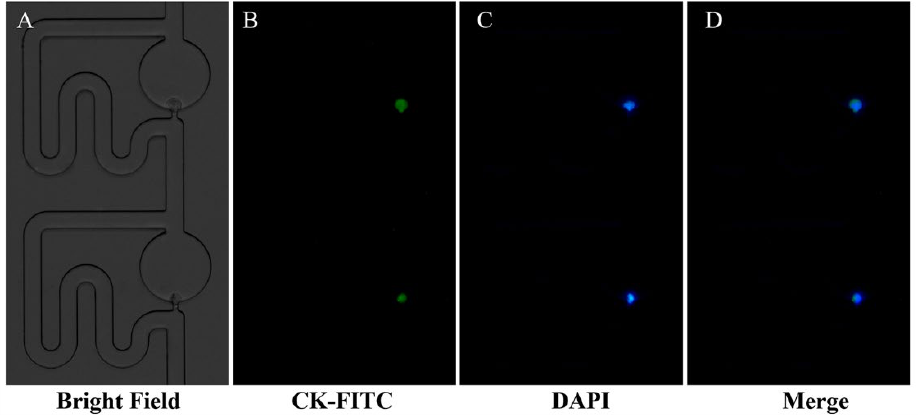
Figure 7. Immunofluorescence staining on the proposed chip. ( A ) Bright field image of the single-cell trapping. ( B ) Fluorescence images of cells stained with CK-FITC. ( C ) Fluorescence images of cells stained with DAPI. ( D ) Fluorescence merged images of cells stained with CK-FITC and DAPI.